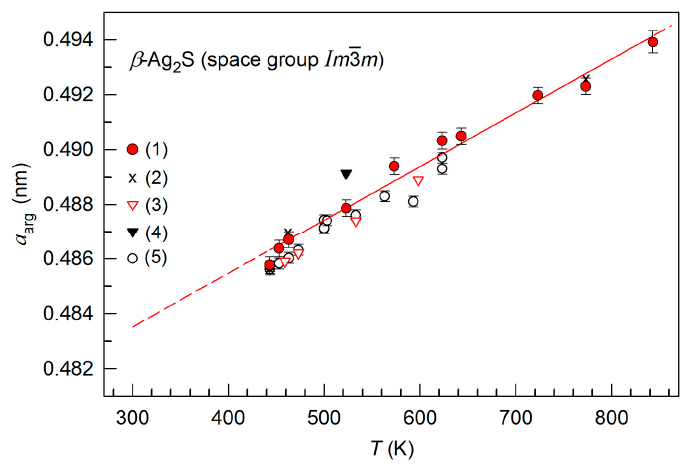
Figure 4. Temperature dependence of the lattice period a arg for argentite: (1) present work; (2), (3), (4), and (5) are the data [42,64–66], respectively. A solid line depicts the approximation of measured period a arg by linear function (2) in the temperature region 443–843 K.